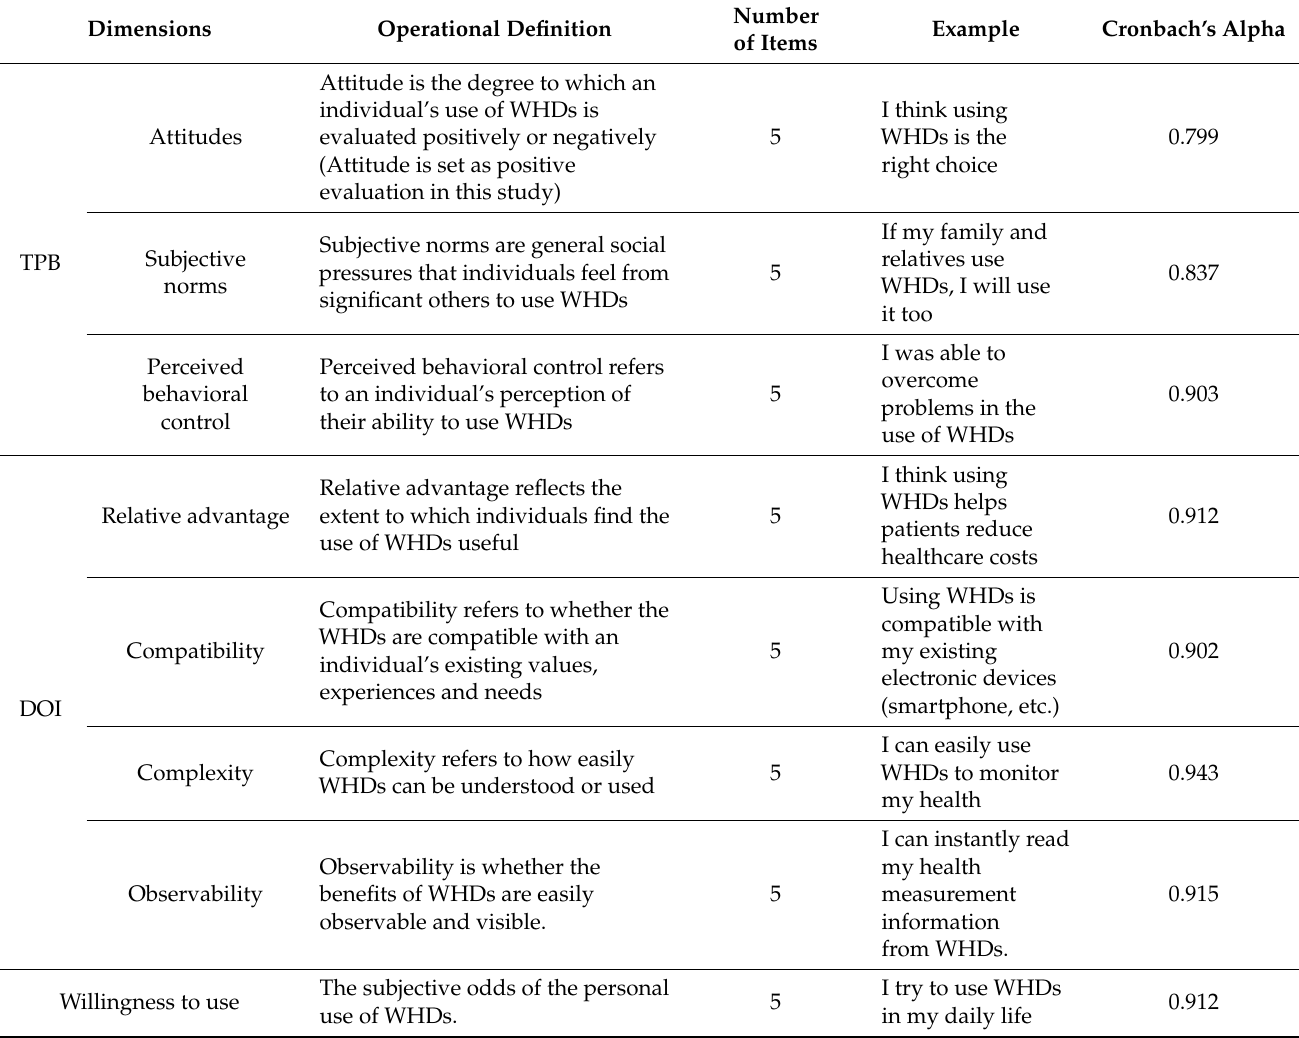
Table 1. Results of Reliability Test of Theoretical Dimensions and